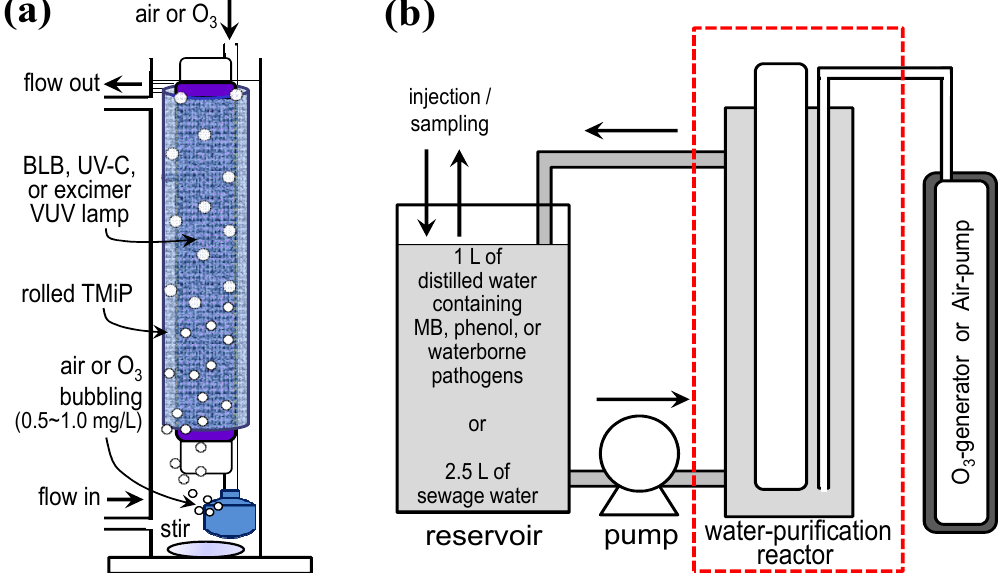
Figure 2. Schematic illustrations of ( a ) water-purification reactor and ( b ) water-purification system. Reproduced with permission from Ochiai et al . [10,14,16], Catalysis Science and Technology; published by RSC Publishing,